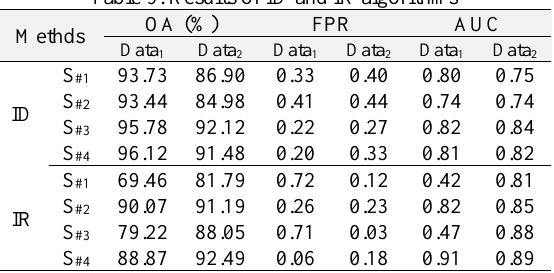
Figure 8. Output change map in IR algorithm for Data